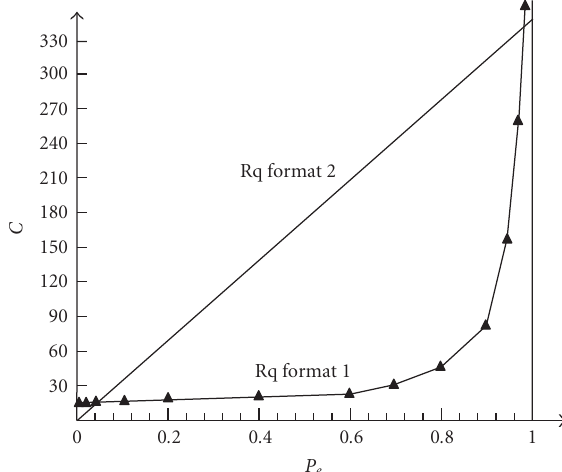
Figure 9: Estimated capacity of a request packet versus packet error rate.